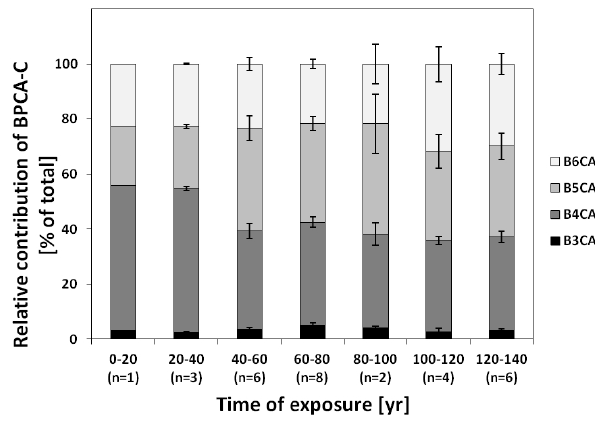
Fig. 4. Average patterns of benzene rings in proportion to total BPCA-C, showing a trend towards larger contributions of B6CA in soil material on older surfaces. Outlier AS6 is included in the age group 100–120. The standard error is given for samples of the corresponding group of time of exposure.